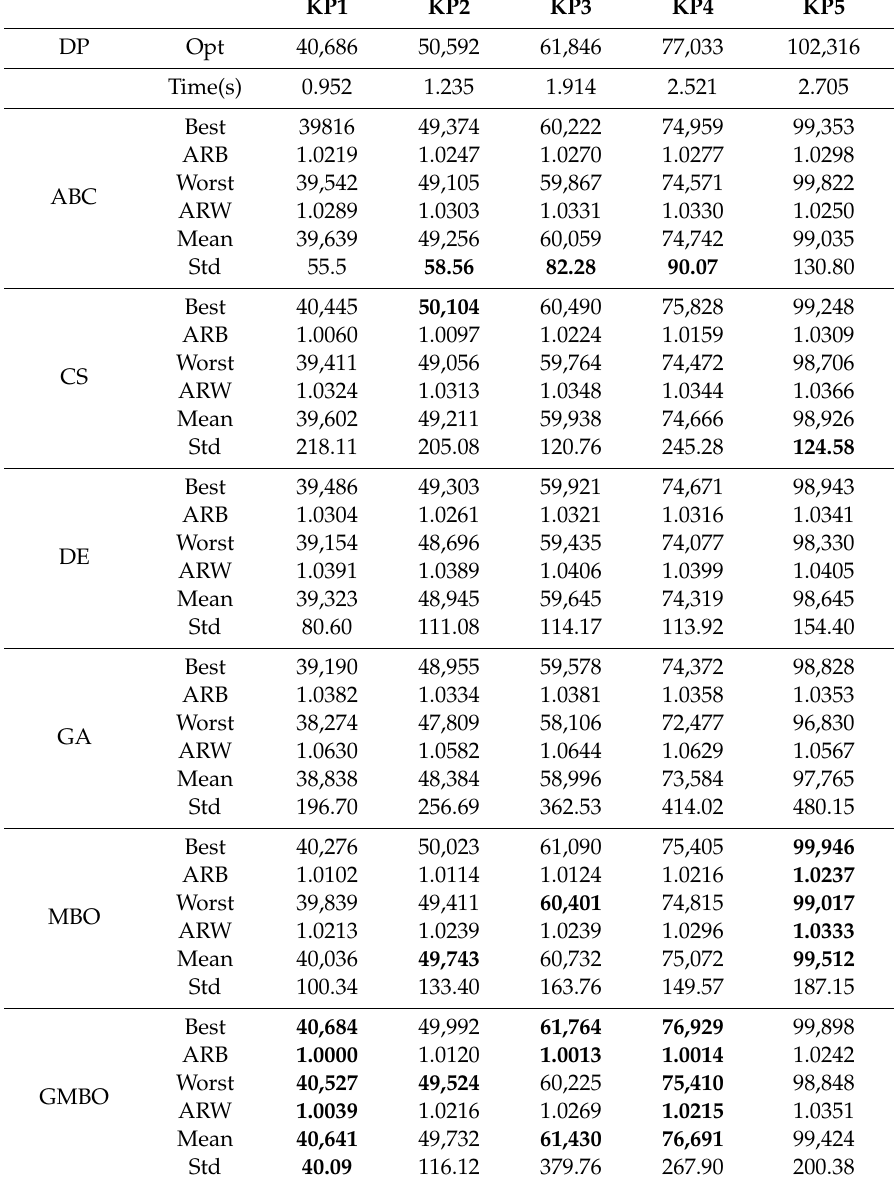
Table 8. Performance comparison on large-scale five uncorrelated 0-1KP instances.